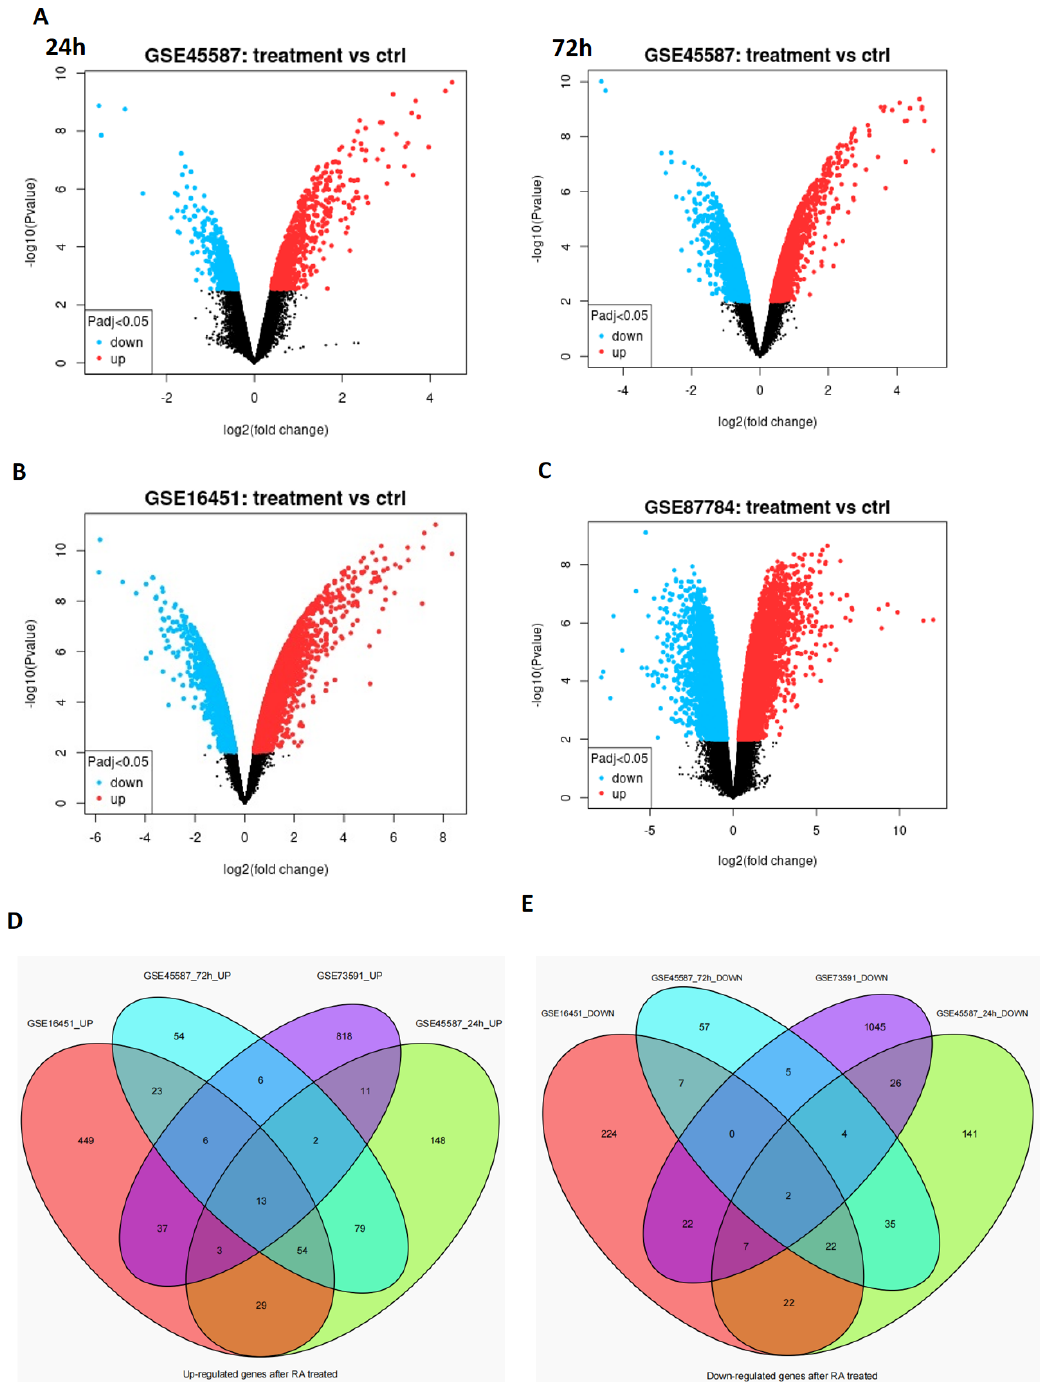
Figure 1. Volcano plot distribution of DEGs and the overlapping DEGs of the four GEO datasets. The volcano plot of ( A ) GSE45587: NB cell line BE(2)-C cells treated with RA for 24 h and 72 h, ( B ) GSE16451: BE(2)-C cells treated with RA for 3 weeks, and ( C ) GSE87784: Sphere cells from TH-MYCN mice treated with RA for 3 weeks. The blue points indicate the downregulated DEGs, red points indicate the upregulated DEGs, and the gray points indicate the genes without significant changes. All DEGs were screened based on an adjusted p value < 0.05 and |log2(fold change)| > 1. ( D ) The overlapping upregulated DEGs and ( E ) the overlapping downregulated